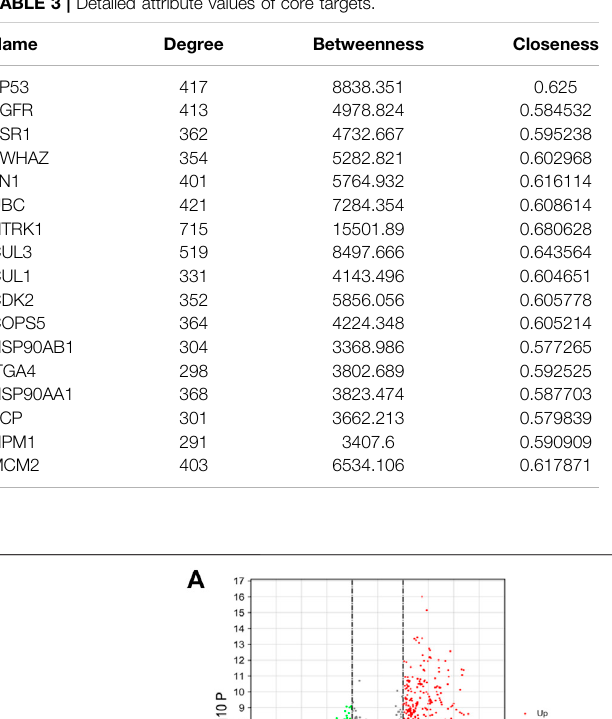
TABLE 3 | Detailed attribute values of core targets.